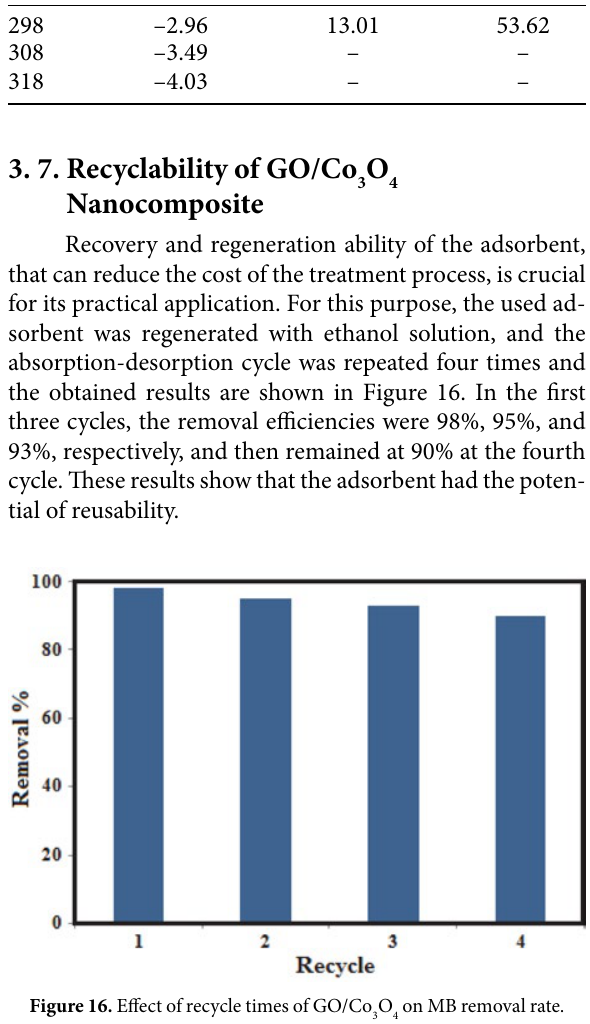
Figure 16. Effect of recycle times of GO/Co